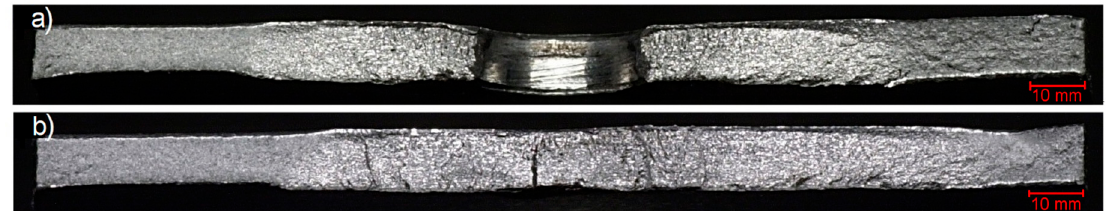
Figure 5. Examples of crack morphology: through-hole ( a ) and in proximity of the hole ( b ).